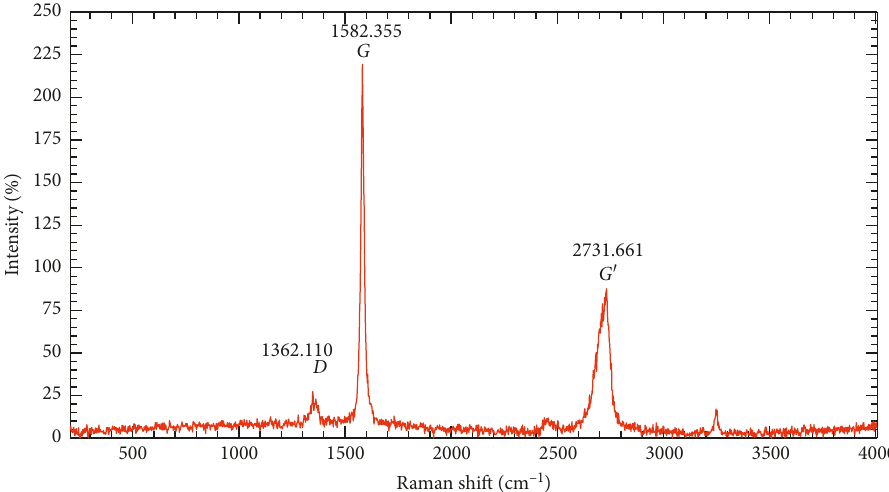
Figure 2: Raman spectroscopy of graphene nanoplatelets at 514nm excitation